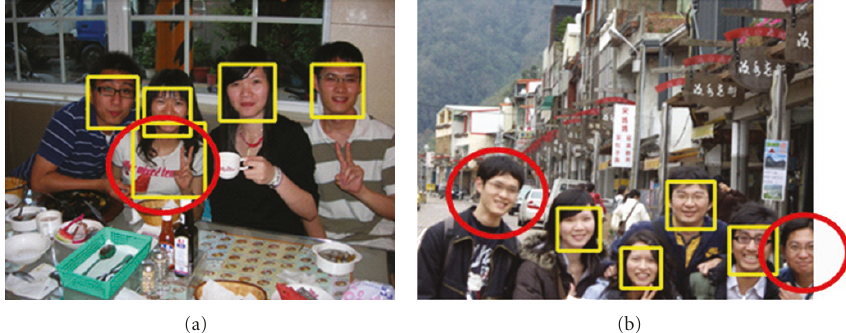
Figure 24: Examples of detection failures in (a) false detection, and (b) missed face regions.